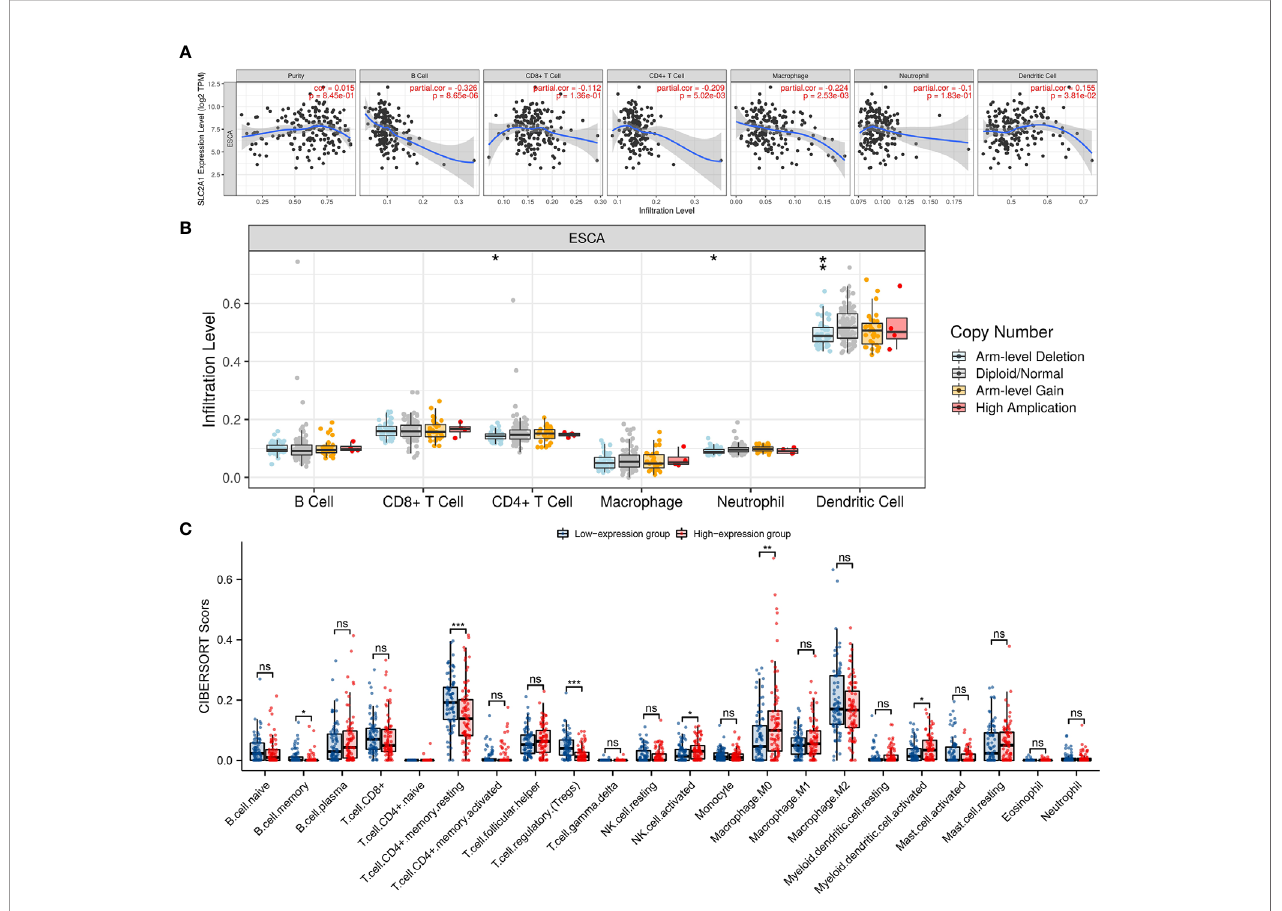
FIGURE 3 | Correlations of GLUT1 expression with immune in fi ltration level in esophageal carcinoma (ESCA). (A) The expression of GLUT1 was signi fi cantly correlated with in fi ltrating levels of B cell, CD4+T cells, macrophages, and dendritic cells in ESCA. (B) GLUT1 CNV affects the in fi ltrating levels of CD4+T cells, neutrophils, and dendritic cells in ESCA. (C) The change ratio of 22 immune cell subtypes in the high and low GLUT1 expression groups in ESCA tumor samples. * p < 0.05; ** p < 0.01; *** p < 0.001; **** p < 0.0001. ns, not signi fi